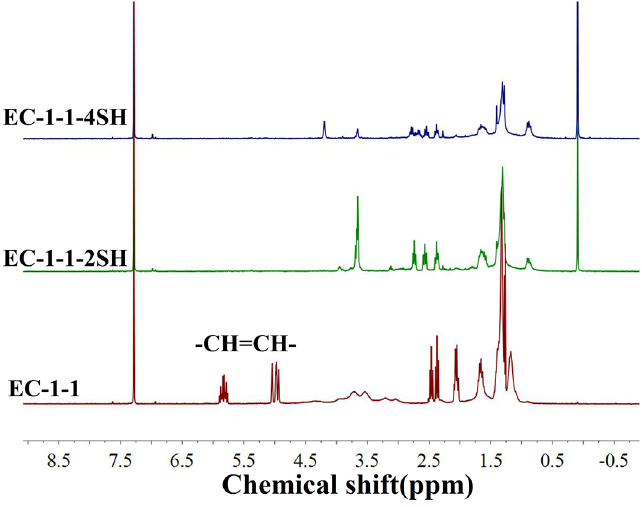
Figure 8. 1 H NMR of EC cross − linked polymer compared with that of EC − 1 − 1.